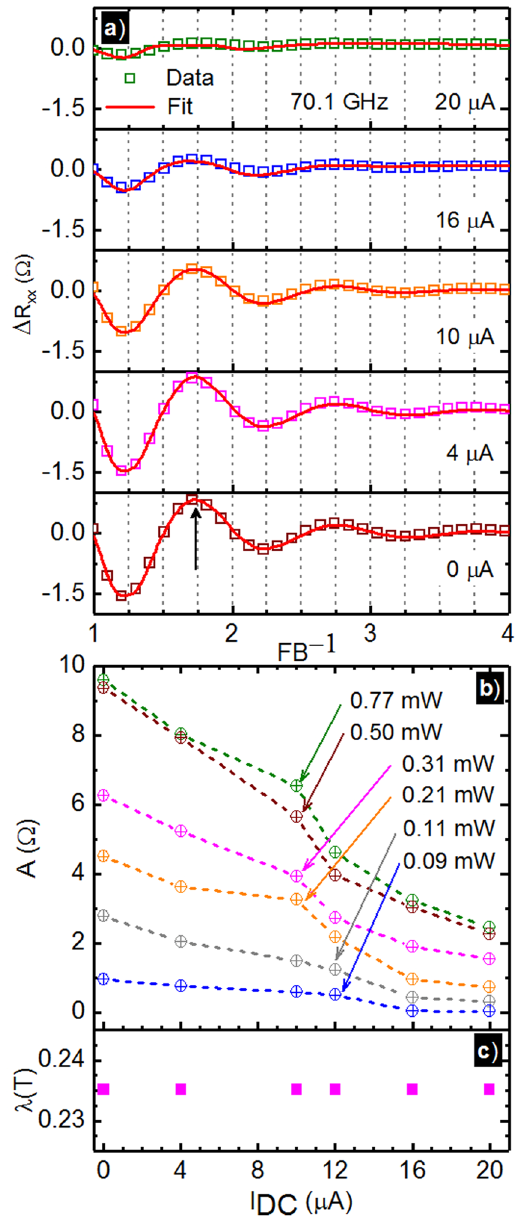
Figure 4. ( a ) This figure exhibits the oscillatory Δ R xx extracted by subtracting the non-oscillatory magnetoresistance from the experimental data at different I dc . The plot shows Δ R xx vs. FB − 1 at various I dc = 0 μ A for P = 0.77 mW . Here, F is the magnetoresistance oscillation frequency and B is the magnetic field. The symbols represent data while the lines represent fits to exponentially damped sinusoids, see text. ( b ) The fit extracted magnetoresistance oscillation amplitude, A , vs. I dc is shown for different P from 0.09 mW to 0.77 mW (circles). The dashed lines are guides to the eye. ( c ) The damping constant, λ , in the exponentially damped sinusoidal fit of the oscillatory magnetoresistance is plotted vs. I dc